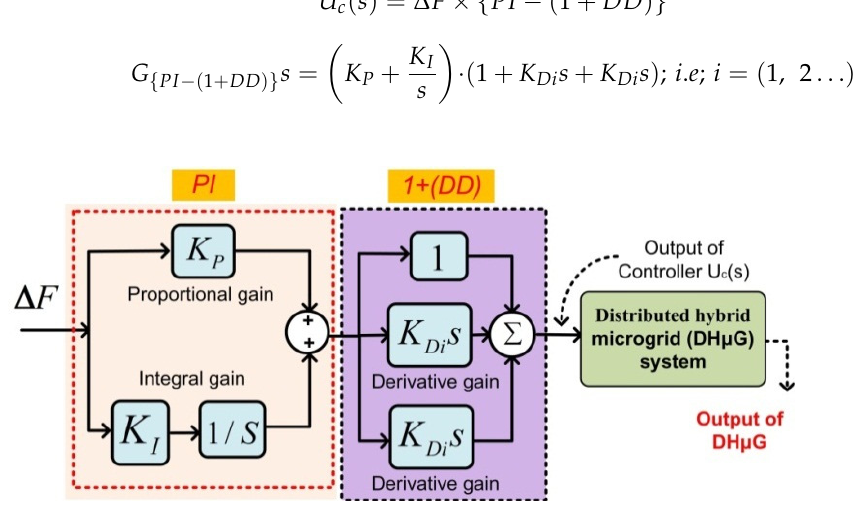
Figure 3. Control structure of the proposed dual level PI − (1 + DD) controller.